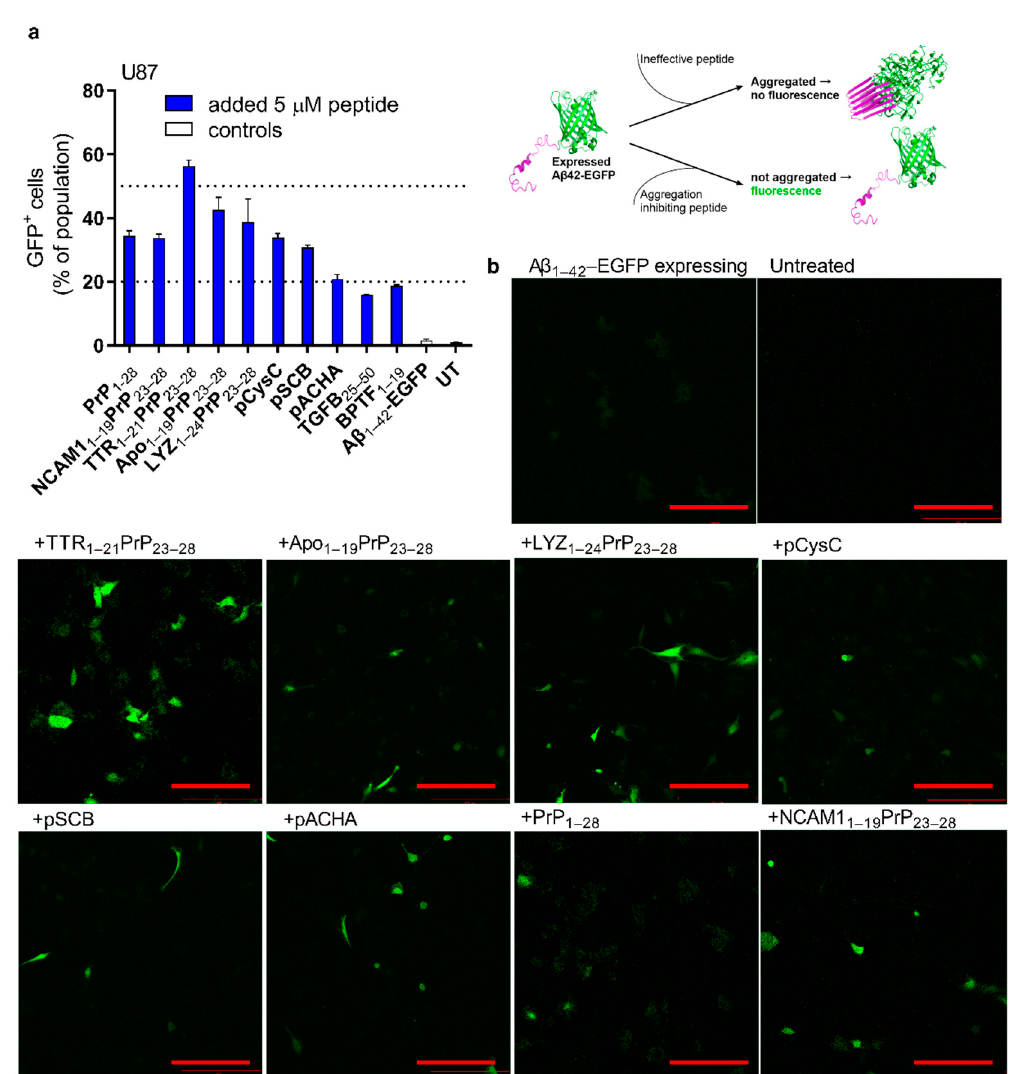
Figure 3. Addition of the peptides leads to the reduction in aggregation. Peptide efficacy was assessed in U87 cells transfected with A β 1–42 -GFP fusion protein expressing plasmid. ( a ) The reduction in the aggregation of the expressed A β 1–42 -GFP assessed with flow cytometry. Cells were transfected with 0.5 µ g A β 42 –EGFP fusion protein expressing plasmid. After 2 h incubation, the cells were washed and the peptides were added at the final concentration of 5 µ M to the cells. 24 h post-addition of the peptides, the cells were detached and cell population with fluorescent signal was detected. To set the threshold for GFP+ cell population, untreated cells were used. ( b ) Confocal microscopy live cell images of controls and cells treated with peptides. After transfection media was replaced with fresh media and peptides were added at the final concentration of 10 µ M. 24 h post-addition of the peptides images were taken to detect fluorescent signal from the expressed and non-aggregated A β 42 –EGFP. Red bar 200 µm. Images were taken with 63× oil immersion objective.